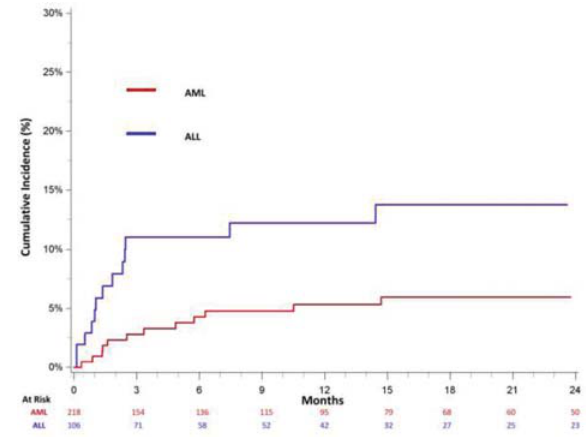
Fig. 2 Cumulative incidence of subsequent venous thromboembo- lism, adjusted for the competing risk of death, among treated California acute leukemia patients with an upper extremity deep vein thrombosis, 2009 to 2014. AML, acute myeloid leukemia; ALL, acute lymphoblastic leukemia.